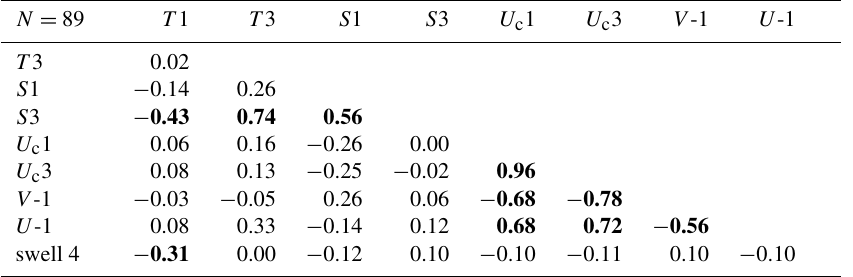
Table 3. Correlation of daily time series in the period December 2012 to February 2013: HYCOM surface layer temperature T , salinity S and zonal current U c (points 1, 3; cf. Fig. 4a), ASCAT wind U V components (point 2) at 1d lead and W3 swell height (point 4). Values > | 0 . 27 | are significant at 90% confidence (bold) with ∼ 40 degrees of